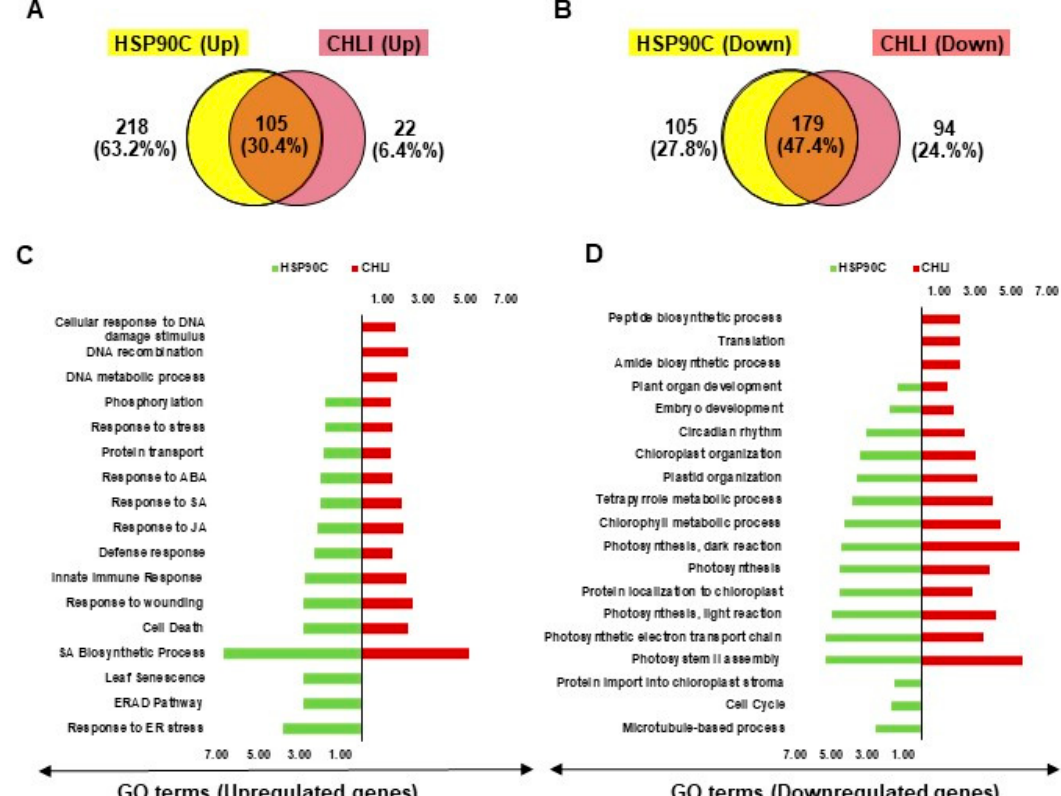
Figure 5. Comparison of chlorosis-related transcriptome changes between i-hpHSP90C and i-amiCHLI transgenic systems. ( A , B ), Venn diagrams showing the commonalities and differences of GO enrichment analyses data with up- (A) and down-regulated (B) genes between two chlorosis models. The overlap part of the circles represents numbers of common GO terms. ( C , D ) Bi-directional plots showing the common and/or unique GO terms significantly (FDR value lesser than 0.05 and Fold Change value greater than 1.0) enriched with up- (C) and down-regulated (D) genes in i-hpHSP90C and i-amiCHLI transgenic systems.